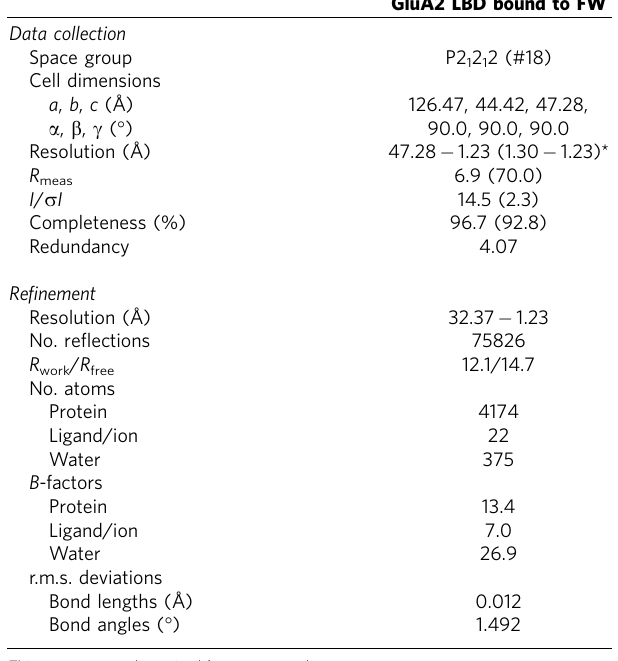
Table 1 | Data collection and refinement